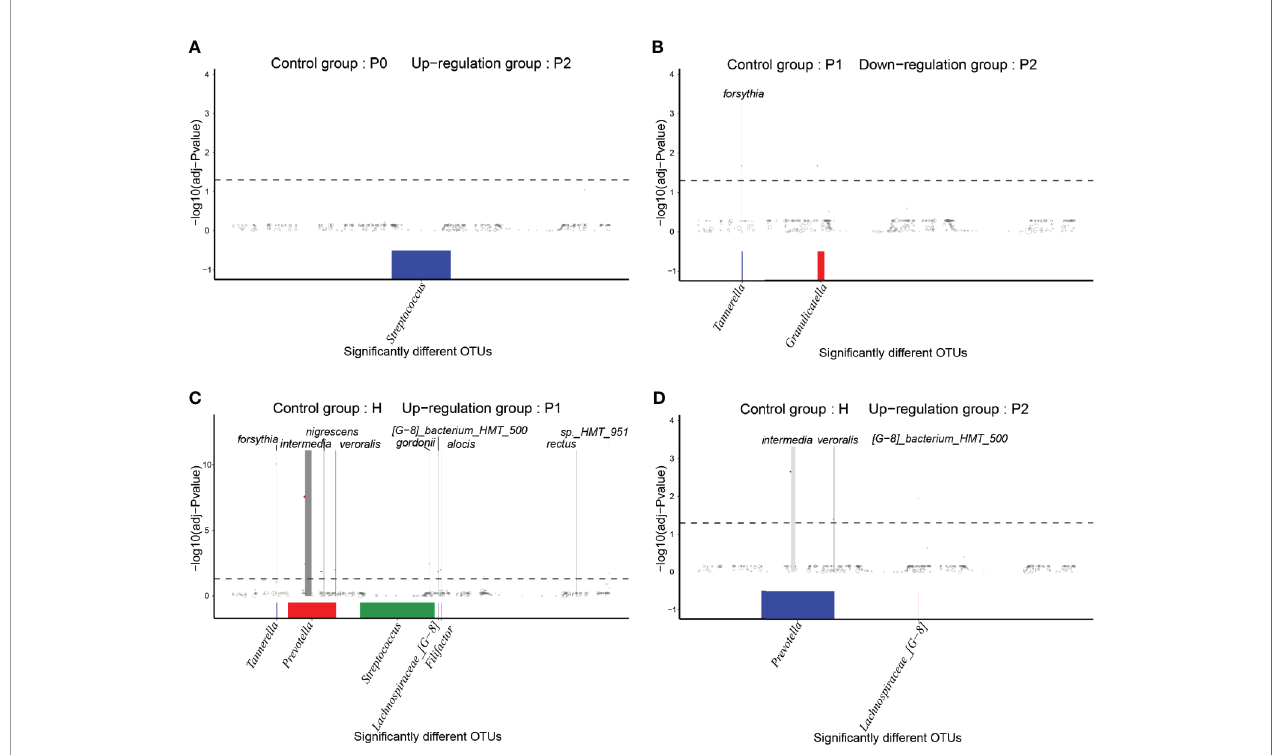
FIGURE 5 | MetagenomeSeq analyses of signi fi cantly different taxa (occurrence frequency of OTUs in the upregulated group was greater than 0.3) between different groups. The differential taxa are annotated at the genus level at the bottom and at the species level at the top. (A) Upregulated OTUs in group P2 compared to P0. (B) Downregulated OTUs in group P2 compared to P1. (C) Upregulated OTUs in group P1 compared to H. (D) Upregulated OTUs in group P2 compared to